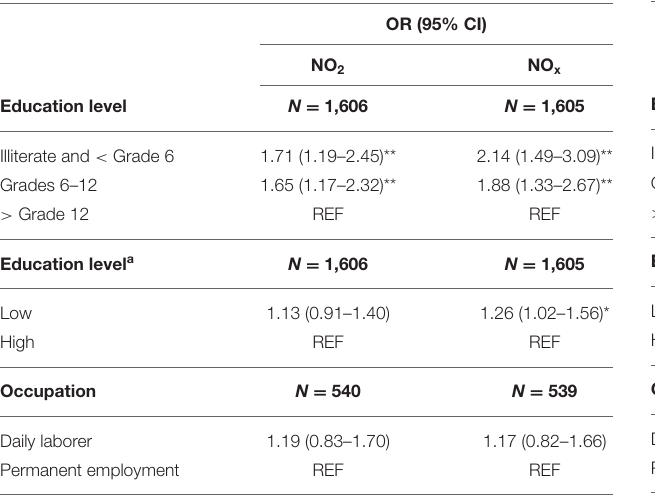
TABLE 2 | Odds of being exposed to levels of NO 2 and NO x above the mean (13.70 and 29.89 µ g/m 3 , respectively) associated with education level and occupation among women in the Adama Mother and Child cohort.